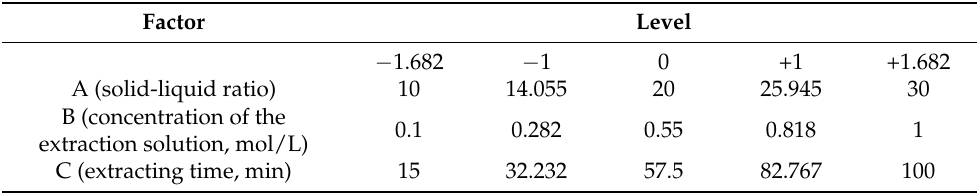
Table 4. Factors and levels of the central composite